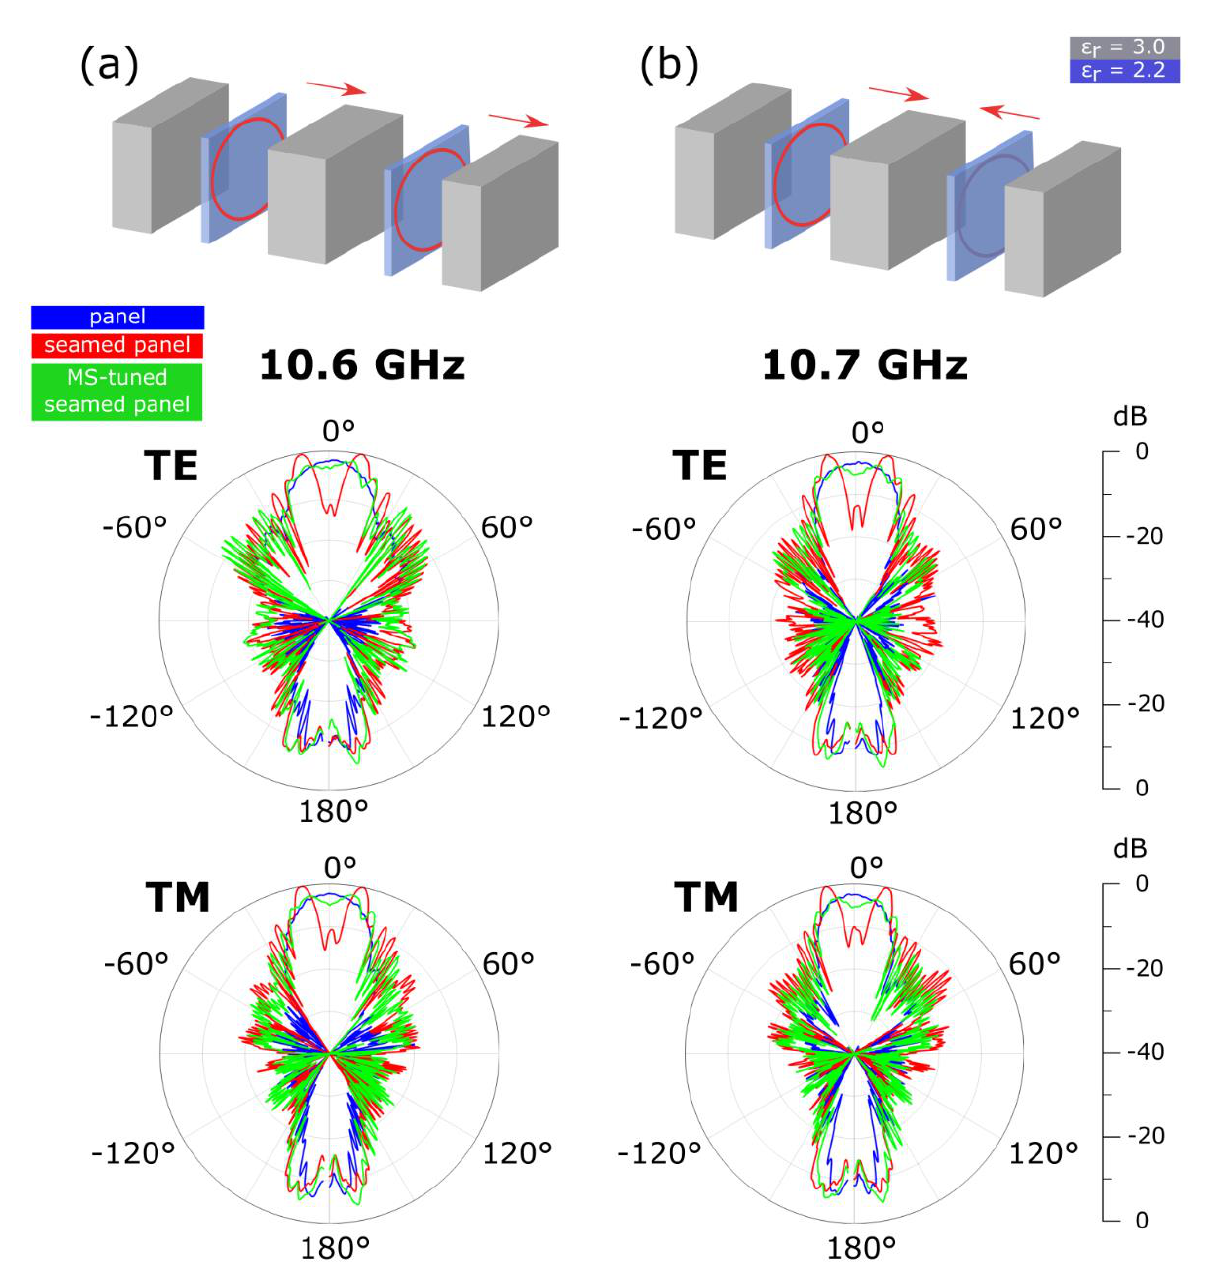
Figure 6. Variations of MS-tuned seam configuration and respective far-field radiation patterns. The red arrows in the schematic indicate the side of the substrate onto which the MS is patterned. ( a ) First variation: the first MS point inward and the second one outward. The scattering reduction effect is achieved at 10.6 GHz. ( b ) Second variation: both MS point inward. The scattering reduction effect is achieved at 10.7 GHz.